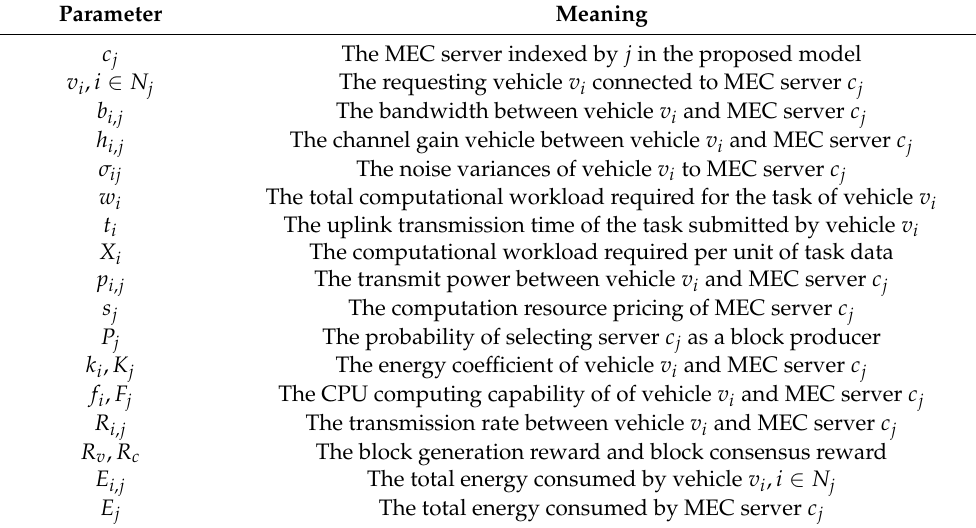
Table 1. The main notation used in this